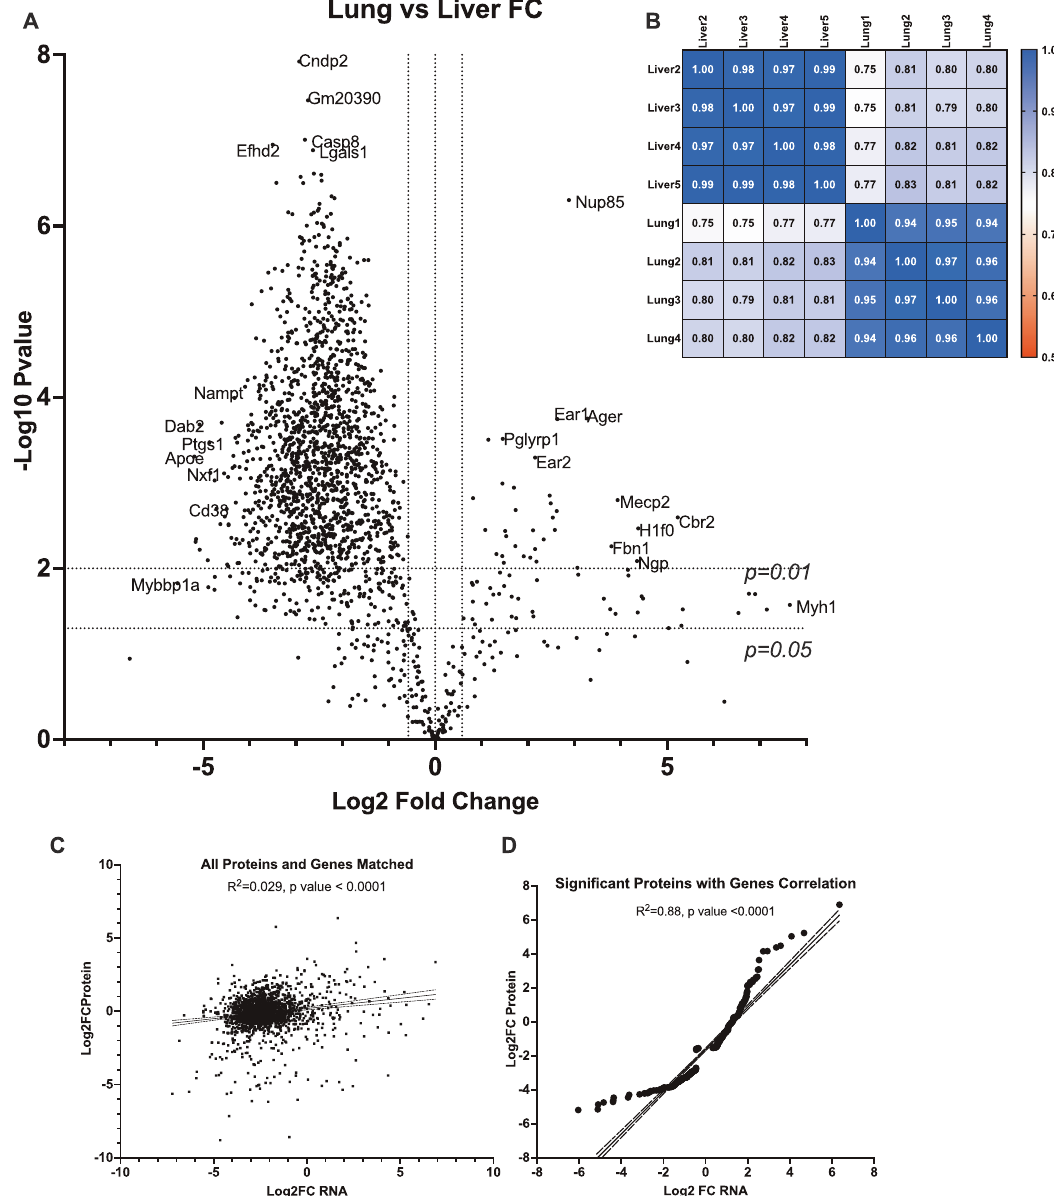
Fig. 2 Comparisons of the global proteomes of LuM and LM and their matching transcriptomic data reveal tissue-speci fi c proteomic signatures. Volcano plot ( A ) and Spearman correlation matrix ( B ) of all 2516 Proteins comparing proteomic changes between LuM and LM. Matching RNA transcriptomic data was found for 2367 proteins whereas signi fi cantly up or downregulated proteins have 317 matching transcriptomic data. Correlation of all 2367 matching proteins and mRNA was low ( C ) but differentially expressed signi fi cant proteins ( D ) correlated well with transcriptomic